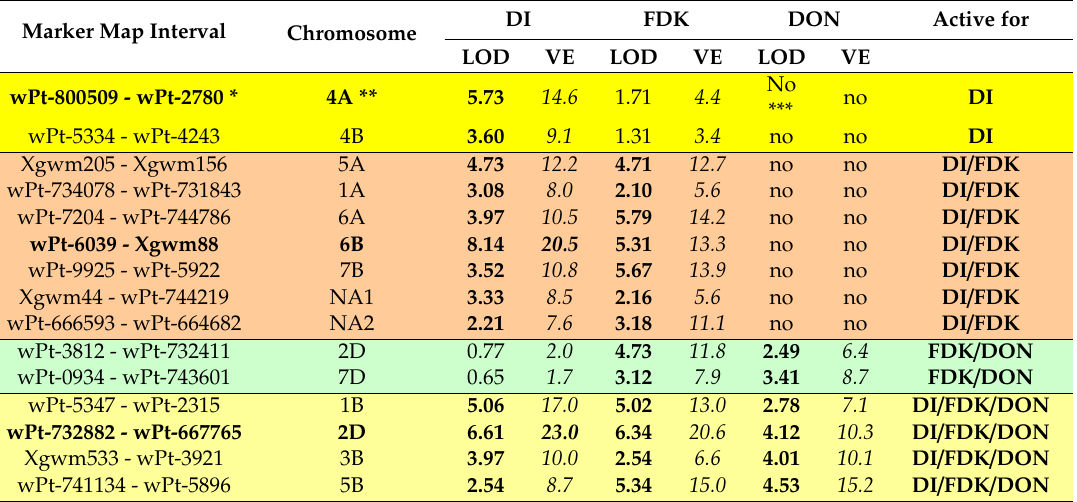
Table 5. Mapping of FHB QTLs in the Mini Mano / Frontana population (168 DH lines including parents) for DI, FDK, and DON, means for seven experiments 2008 and 2009